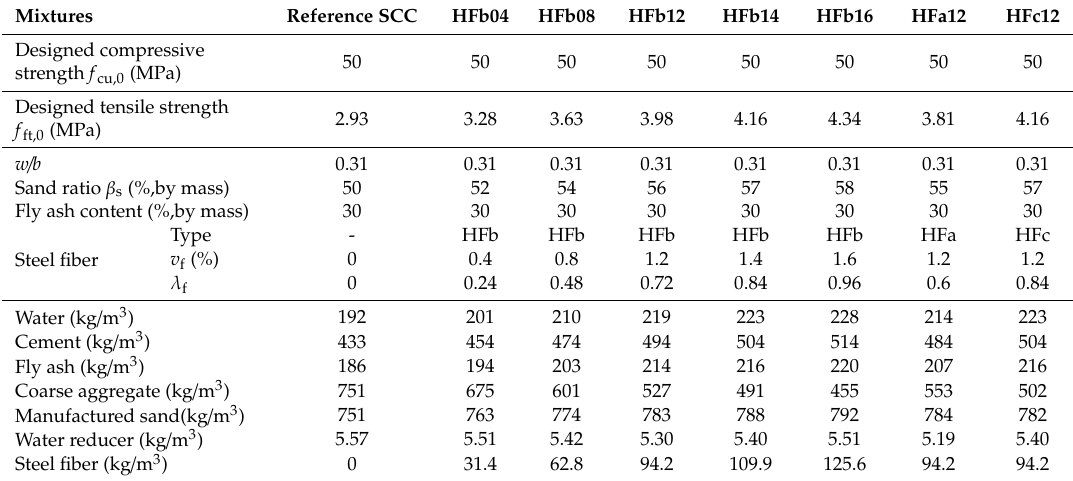
Table 7. Detailed mix proportion of self-compacting steel-fiber-reinforced concrete (SFRC).